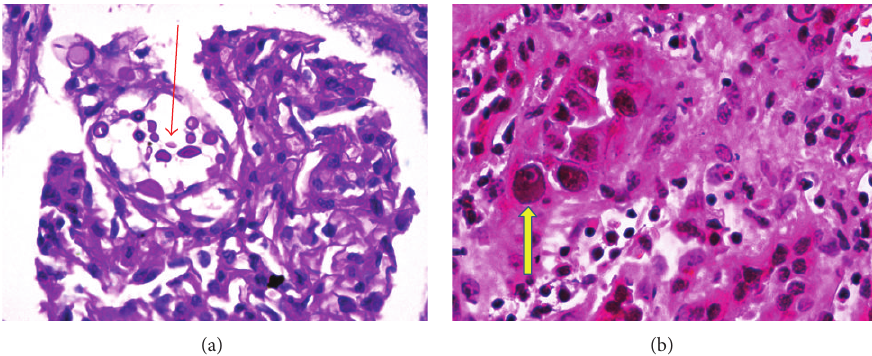
Figure 2: Glomerulus exhibits intracapillary spherical fungal structures that show PAS positive capsules consistent with cryptococcal organism (red arrow). Few of the tubular epithelial cells show homogenous smudgy appearing intranuclear inclusions (yellow arrow).